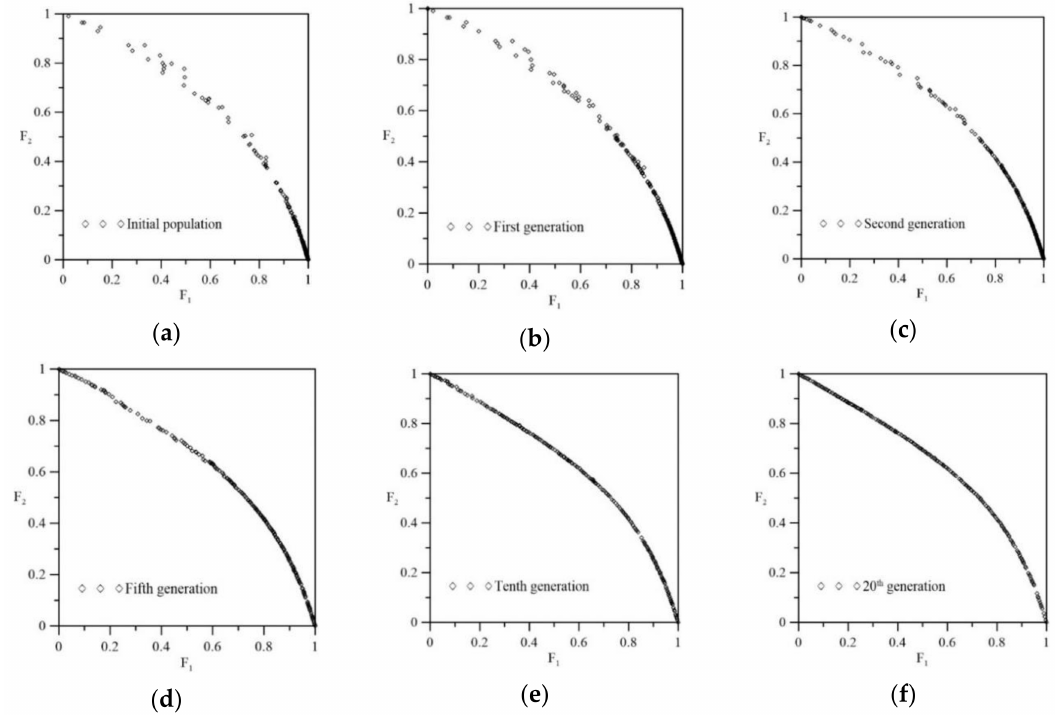
Figure 8. Two hundred populations for different generations shown in the objective spaces, in which the TD material properties are considered; ( a ) initial generation; ( b ) 1st generation; ( c ) 2nd generation; ( d ) 5th generation; ( e ) 10th generation; ( f ) 20th